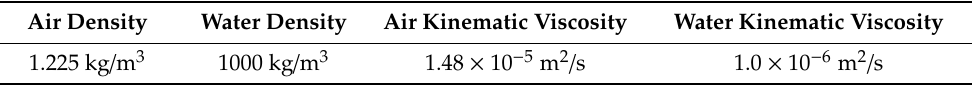
Table 4. Fluid properties used in the